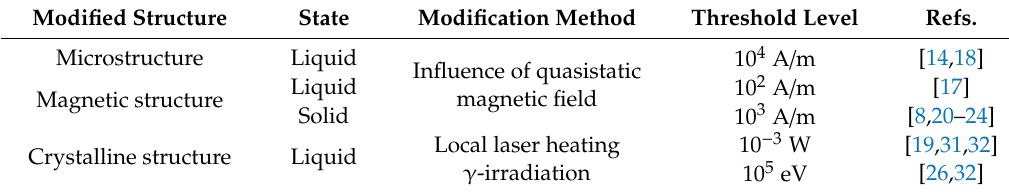
Figure 4. Frequency dependence of the characteristic energy of quanta during the interaction of electromagnetic field with nanocomposites based on the Fe m O n –SiO 2 system in the frequency range 10 13 –10 21 Hz: 15 —absorption on vibrations of Si–O–Si groups (solid), 19 —intrinsic absorption in iron oxide and silica (solid, liquid), 20 —X-ray diffraction on the crystal lattice (solid), 21 —Mössbauer effect (solid), 22 —radiation-induced phase transition magnetite → maghemite (solid). “+” corresponds to a solid state, “ ○ ” corresponds to a liquid state. The dashed line corresponds to the threshold level of change in the crystalline structure. Table 2. Thresholdlevelsofelectromagneticfieldexposurewhenmodifyingthestructureofnanocomposites. Modified